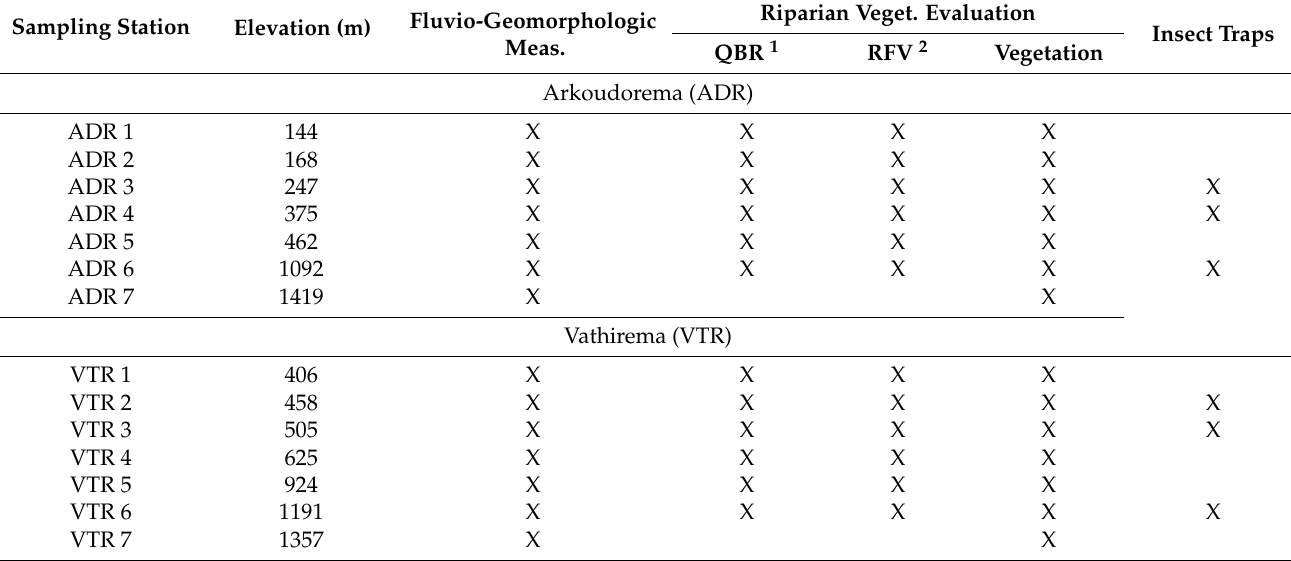
Table 1. The type of measurements taken at each sampling station of the two studied sub-watersheds. The elevation at each sampling stations is also provided, and an X indicates the type of measurements taken at each station. Sampling Station Elevation (m) Fluvio-Geomorphologic